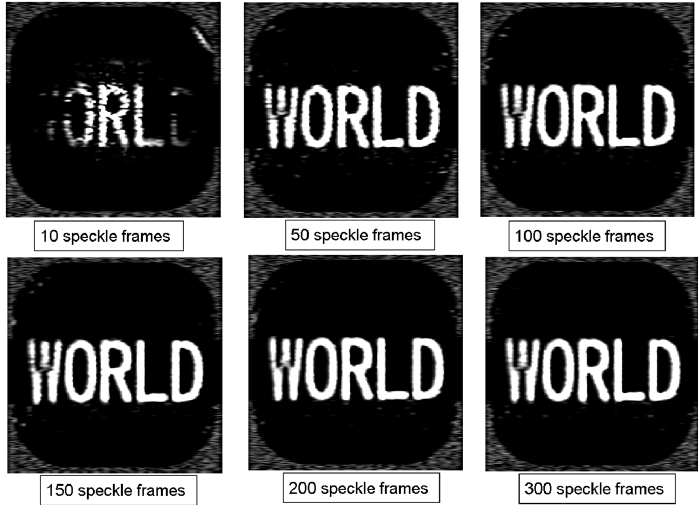
Figure 11. Visual reconstruction results of ptychographic imaging correlography with various speckle frames .